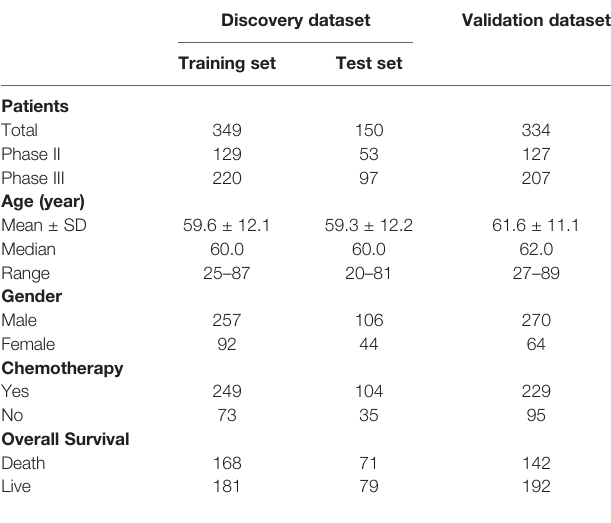
TABLE 1 | Clinical information of patients in this study.